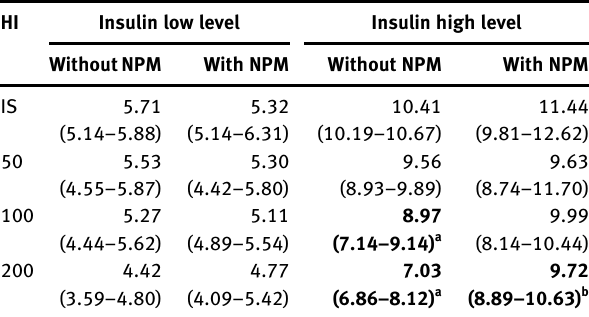
Table  : High and low concentration of insulin (µIU/mL) median values (min – max).